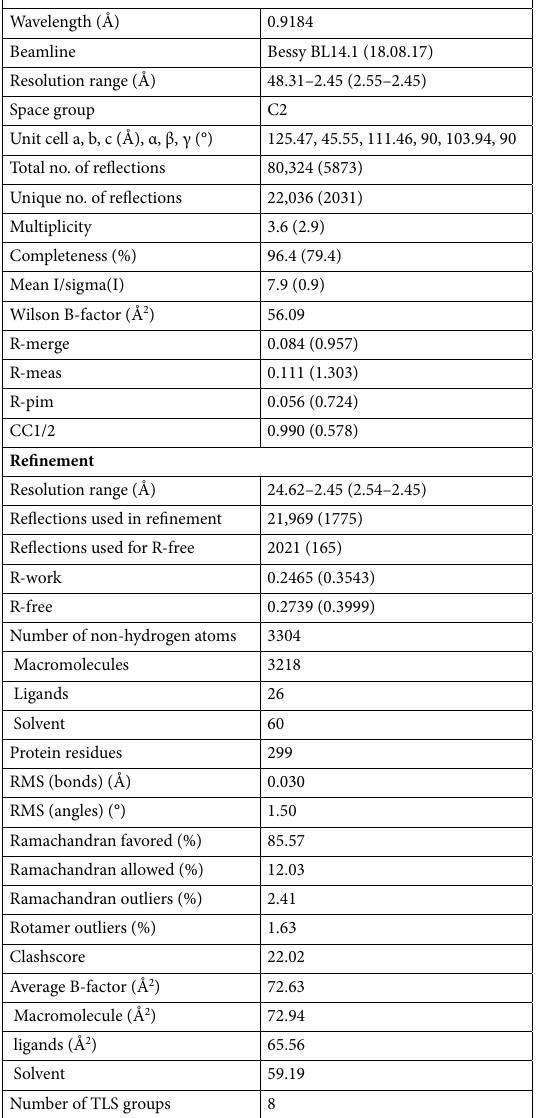
Table 5. Data collection and refinement statistics for the Bsp-lig DNA crystal structure PDB 7OBN.n. Statistics for the highest-resolution shell are shown in